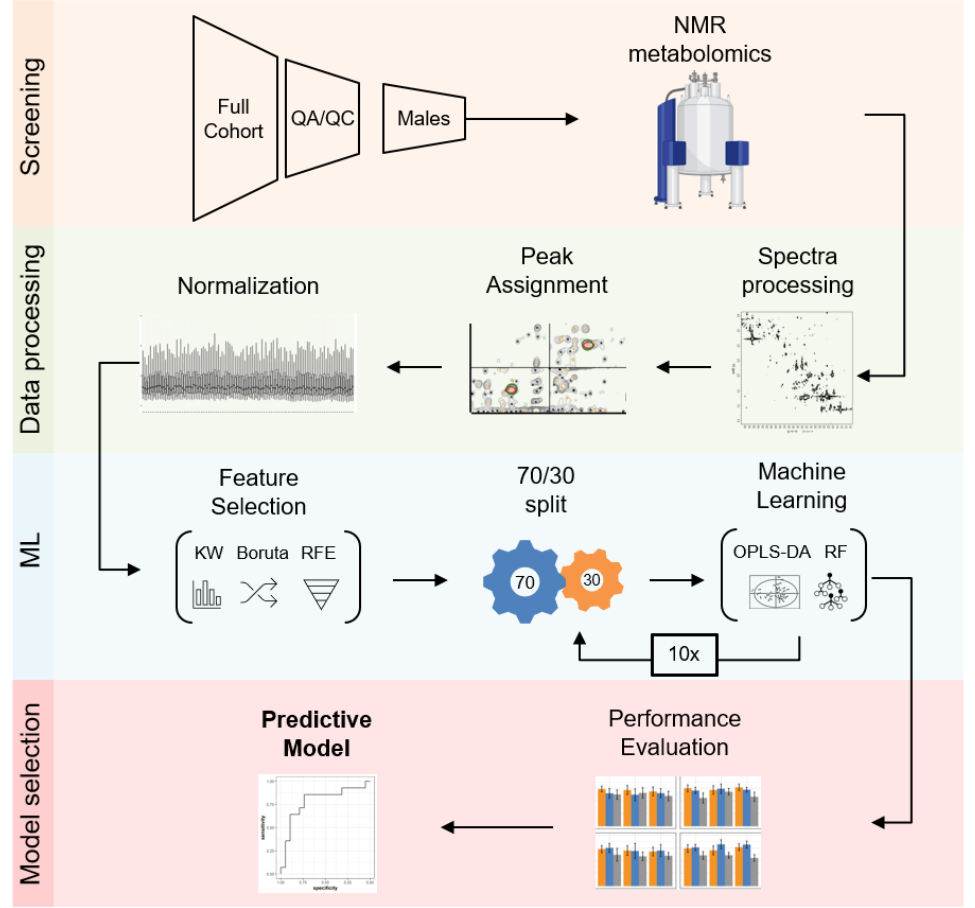
Figure 3. Classifier workflow. Following sample preparation and NMR filtering, raw spectra were processed, resonance peaks assigned to the database-matching metabolites, and the resonances across samples normalized. Modeling comprised feature selection and 10 × cross-validation of OPLS-DA and RF methods. The model with the highest stability and overall performance was selected as the champion model.